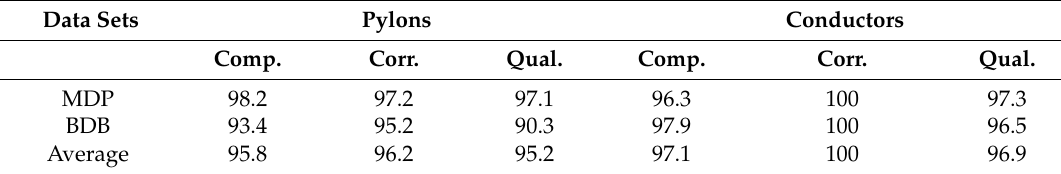
Table 8. Point-based evaluation of pylons and spans on both data sets (all values in percentage). Data Sets Pylons Conductors Comp. Corr.